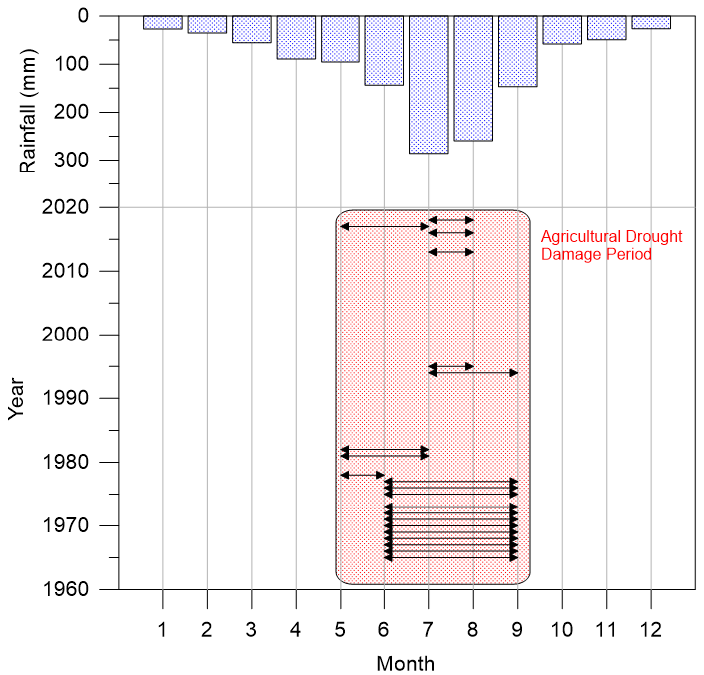
Figure 5. Setting up drought disaster periods in view of damage from agricultural droughts.